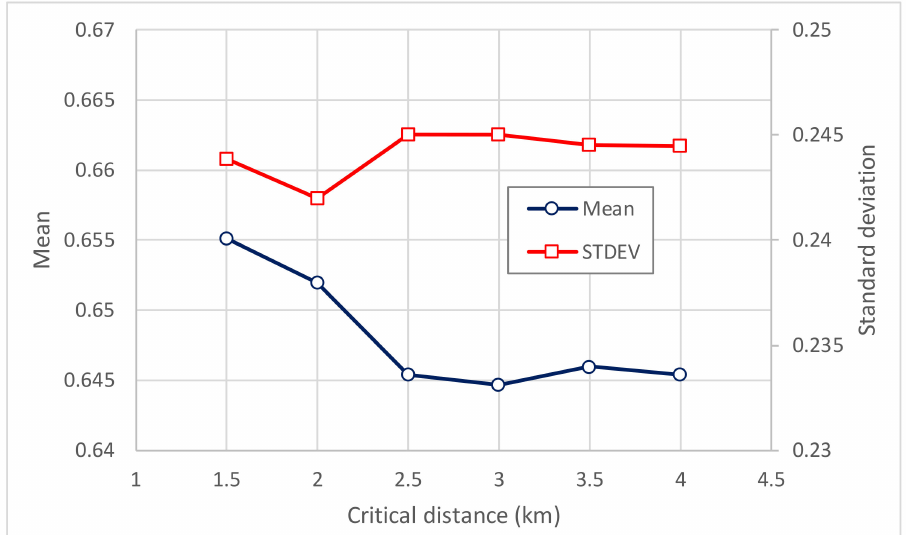
Figure 9. Correlation coefficients and associated statistical properties of inundation depths with the areal average rainfall calculated using the simulated gridded rainfall with specific distances from the IoT sensor of